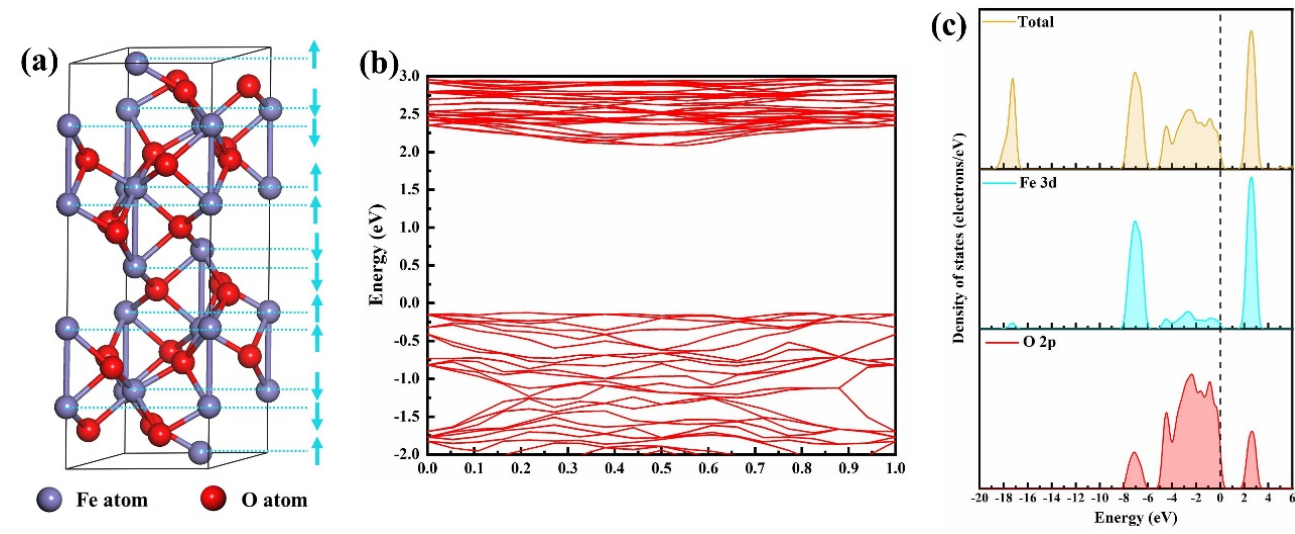
Figure 1. ( a ) The crystal structure and spin arrangement of α -Fe 2 O 3 ; ( b ) the band structure of α -Fe 2 O 3 ; and ( c ) the DOS and PDOS analysis of α -Fe 2 O 3 .